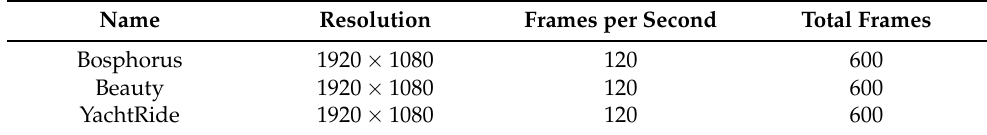
Table 5. UVG video